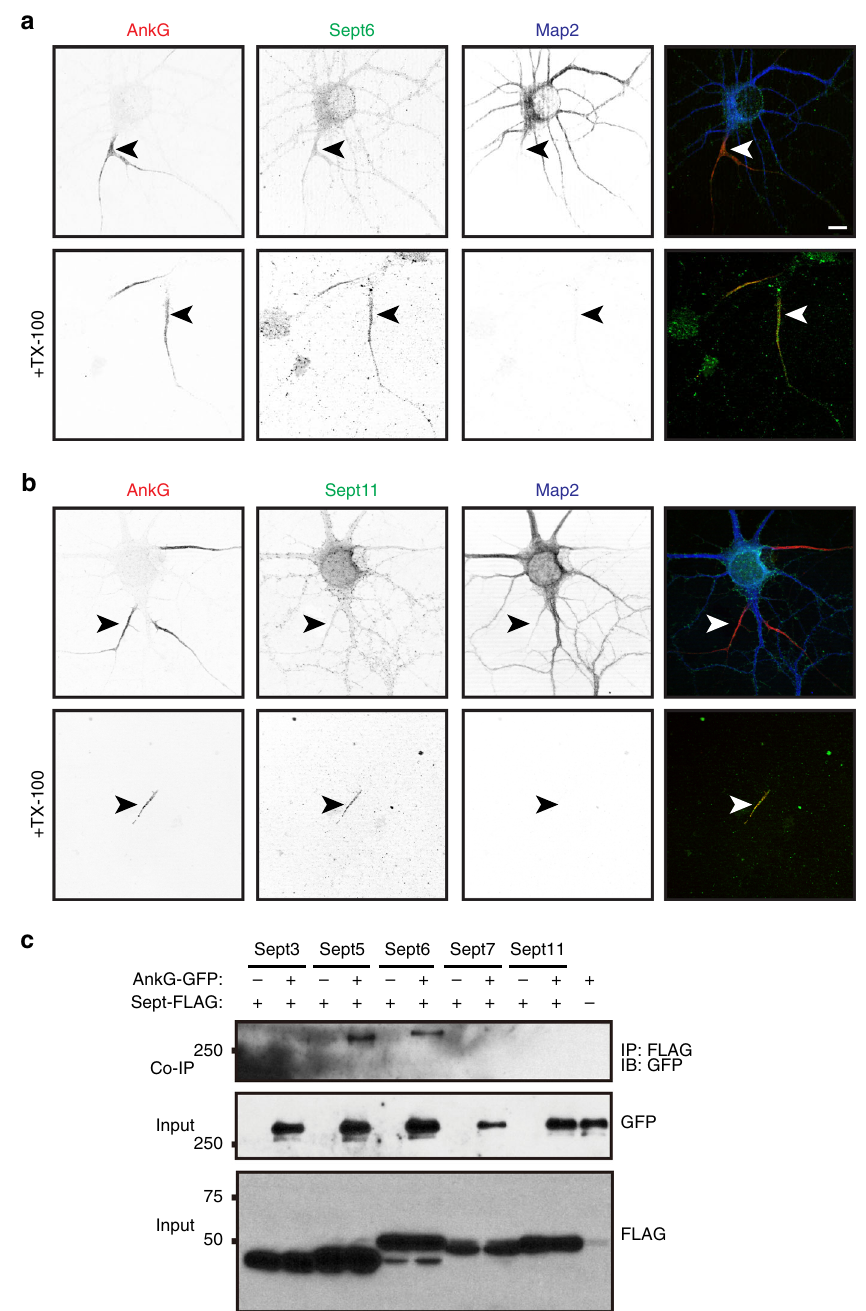
Fig. 5 A detergent insoluble pool of AnkG-associated Septins is located at the AIS. a , b Immunostaining of DIV14 hippocampal neurons using antibodies against AnkG (red), Sept6 ( a , green), Sept11 ( b , green) and Map2 (blue). The lower panels show the Triton X-100 detergent-resistant pools of Sept6 ( a ) and Sept11 ( b ) at the AIS. AIS are indicated by arrowheads. Scale bar = 5 μ m. c In vitro co-immunoprecipitation shows AnkG-GFP co-immunoprecipitates with Sept5-FLAG and Sept6-FLAG. IP immunoprecipitation, IB immunoblotting. Molecular weight markers are in kilodaltons. Source data are provided as a Source Data fi